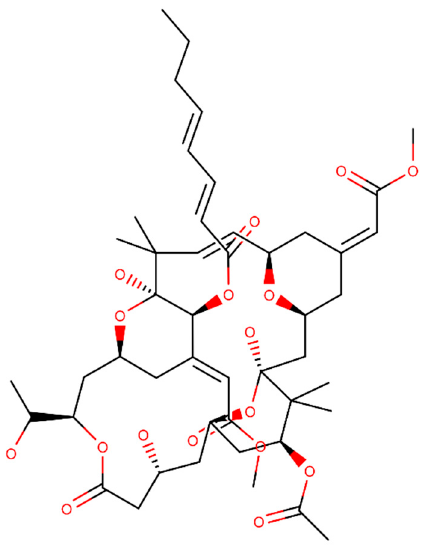
Figure 6. Chemical structure of bryostatin.